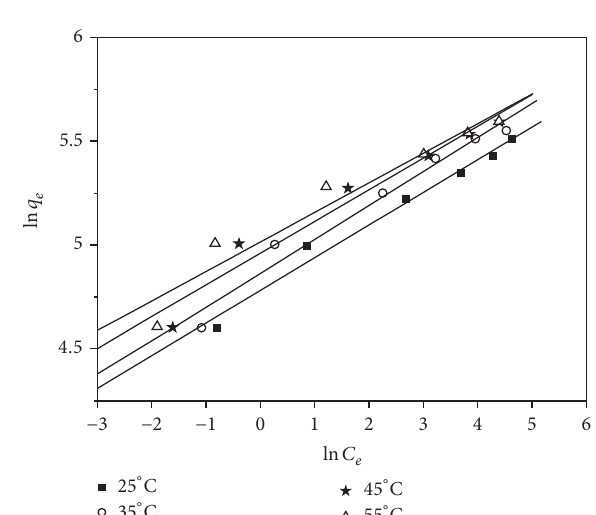
F 7: Freundlich isotherm plots for MB adsorption at different